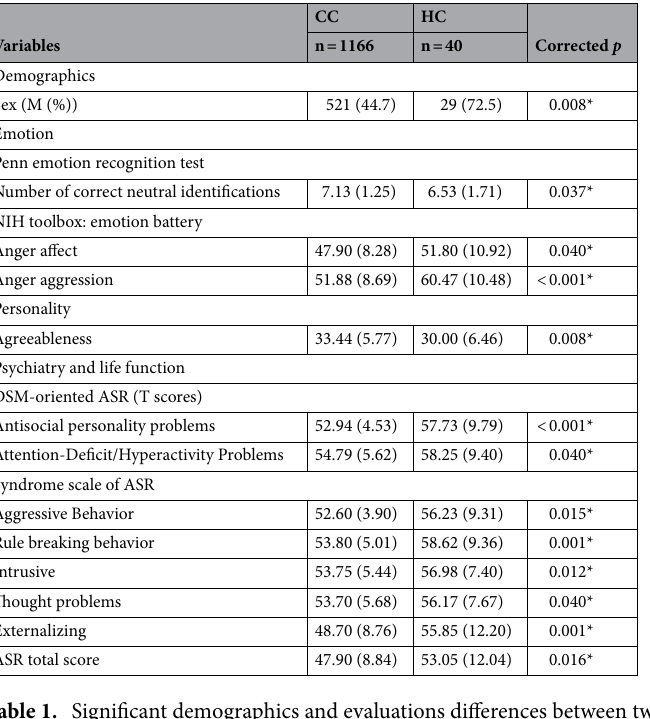
Table 1. Significant demographics and evaluations differences between two groups. HC healthy controls with no history of conduct, CC childhood conduct history, M male, DSM the diagnostic and statistical manual of mental disorders, ASR adult self-report.